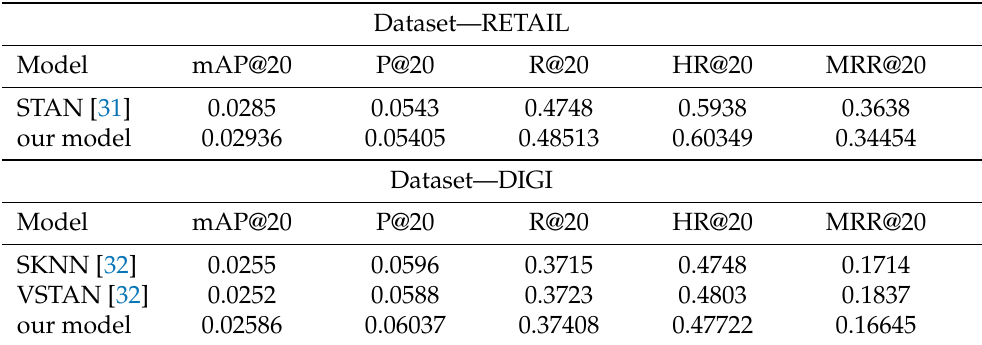
Table 2. Comparison of performance on our models and currently published SotA in session-based recommenders research. Metrics are commonly used in the task [30].